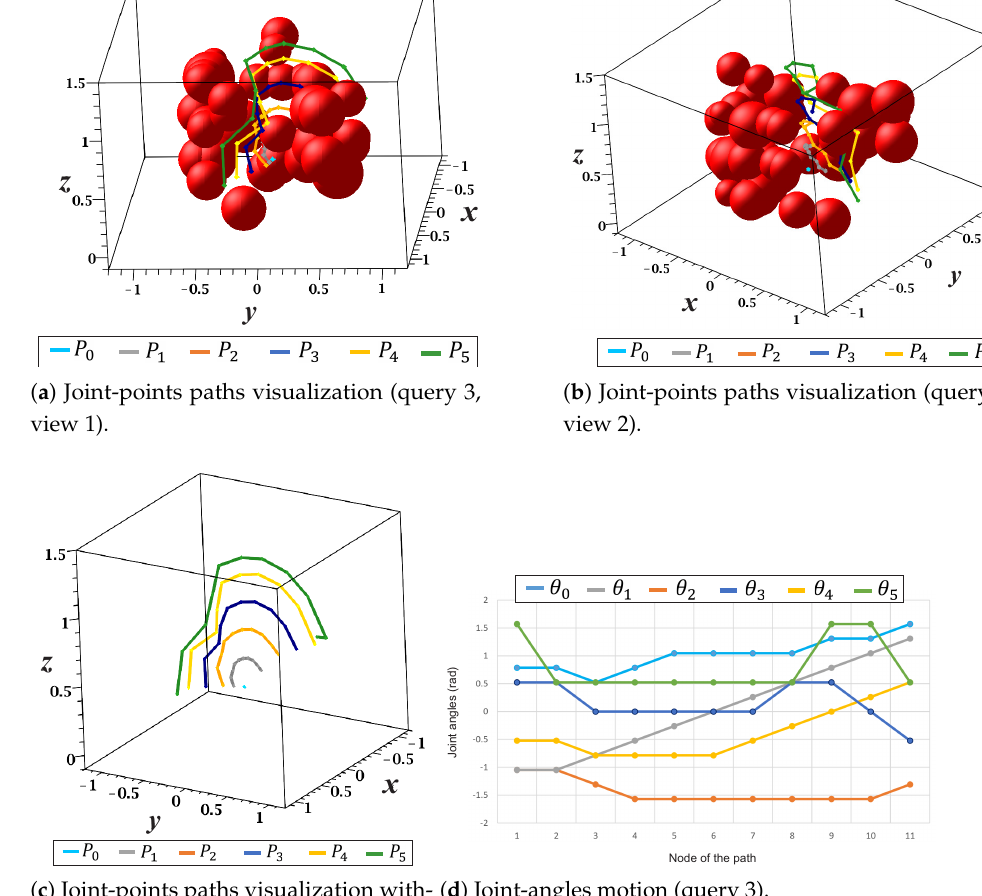
Figure 26. Joint-points paths and joint-angles motion (query